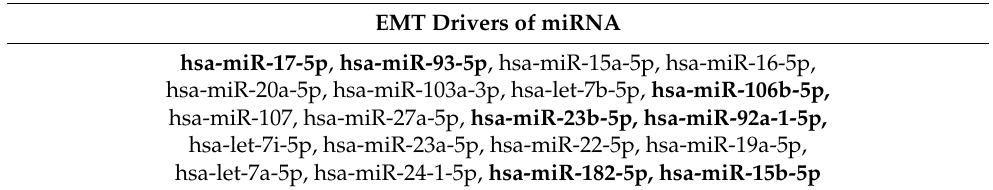
Table 2. Top 20 miRNA EMT drivers, with the names of predicted drivers validated by [56] in